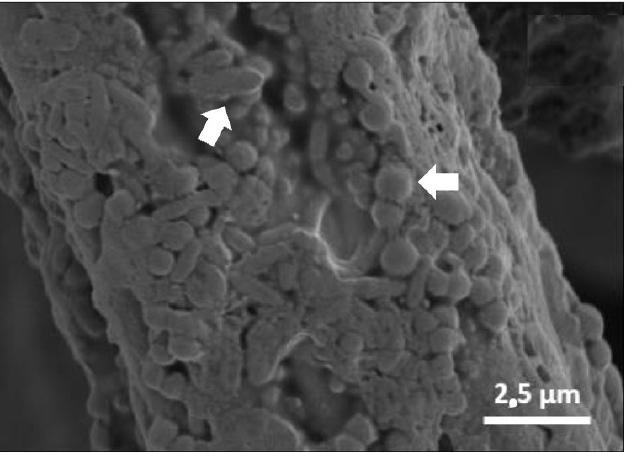
Figure 4. Microorganisms present in the anode biofilm from a scanning electron microscope.